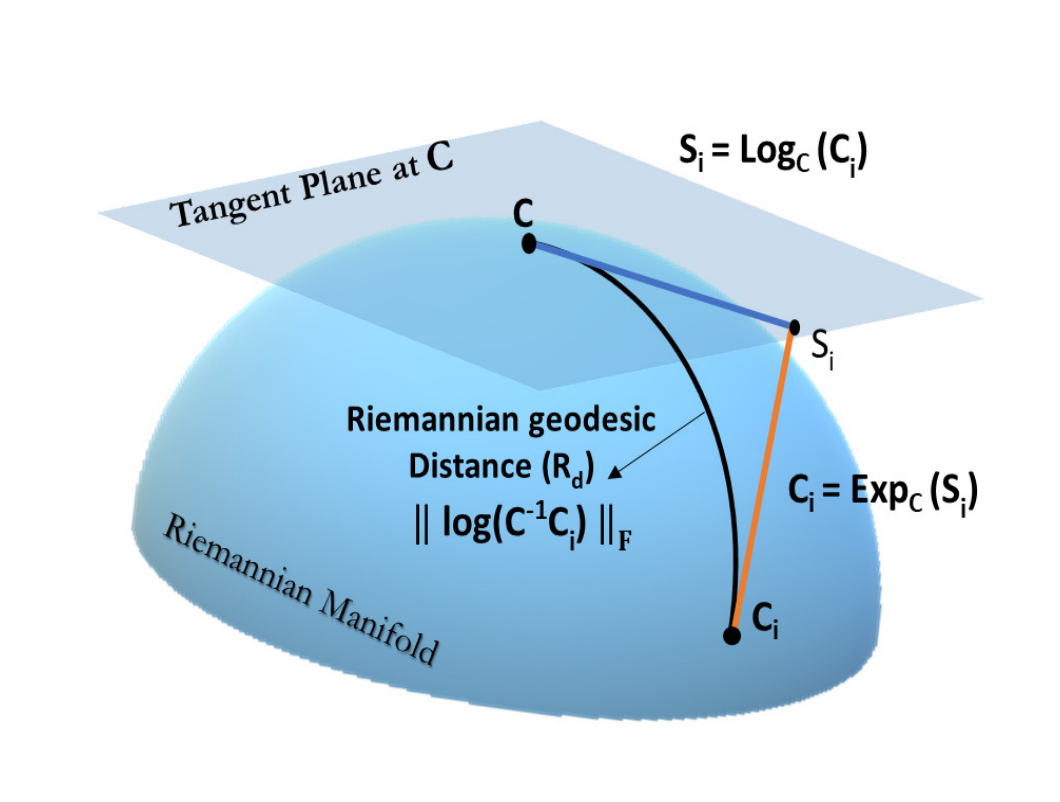
Figure 5. An image of the Riemannian Manifold displaying an example of a geodesic (the shortest distance between two Riemannian points), tangent space, and tangent